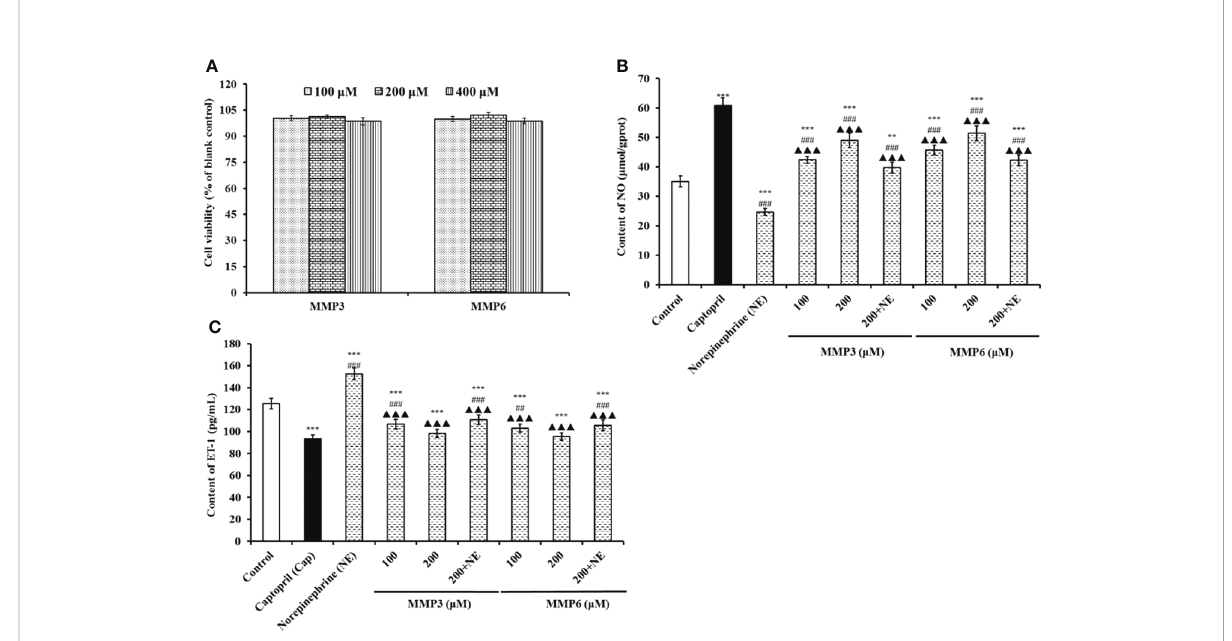
FIGURE 6 The effects of MMP3 and MMP6 on the cell viability (A) , NO production (B) , and ET-1secretion (C) of HUVECs, respectively. Captopril (Cap) was designed as a positive control. All values are means ± SD (n= 3). *** P < 0.001 VS Control; ## P < 0.01 and ### P < 0.001 VS Cap; ▲▲▲ P < 0.001 VS Norepinephrine